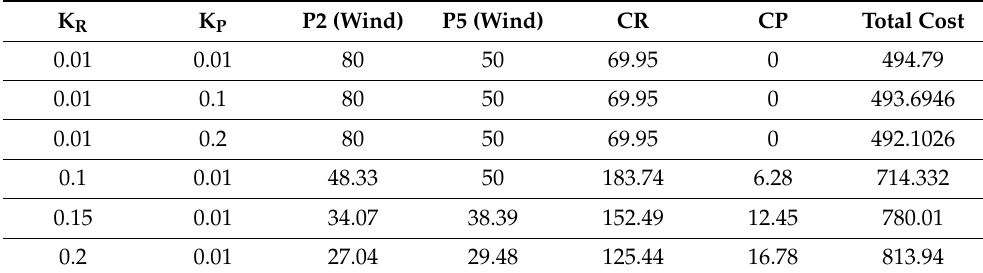
Table 6. Optimal value for scheduled